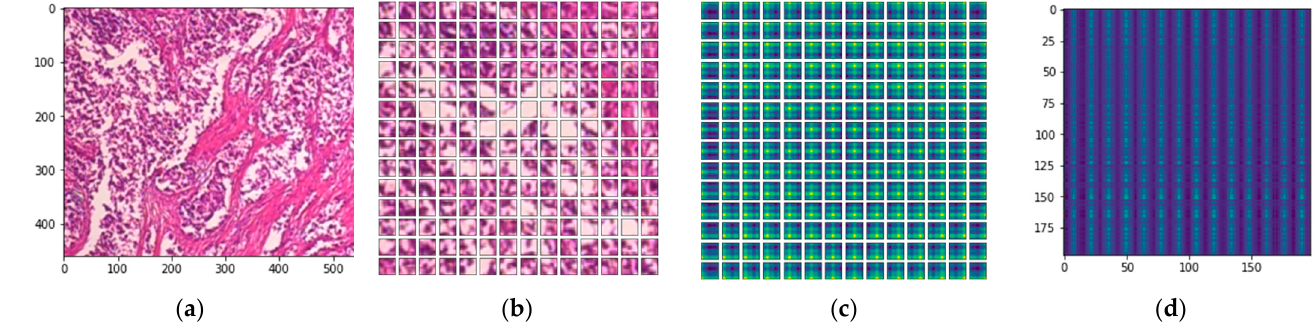
Figure 9. the visualization of the implementation steps of the DEEP_Pachi model. ( a ) depicts the input image, ( b ) the input image patches, ( c ) learnable position embedding of the input image patches, and ( d ) attention matrix.